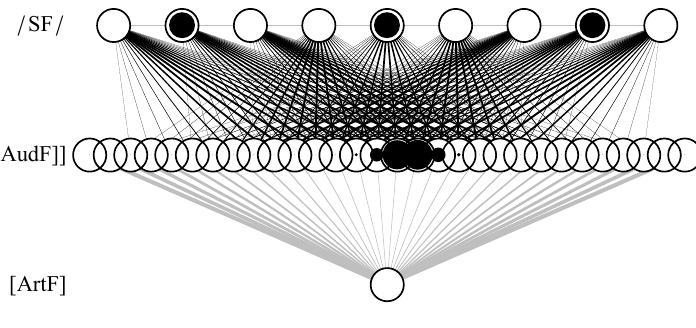
The neural network after 50,000 pieces of confusing